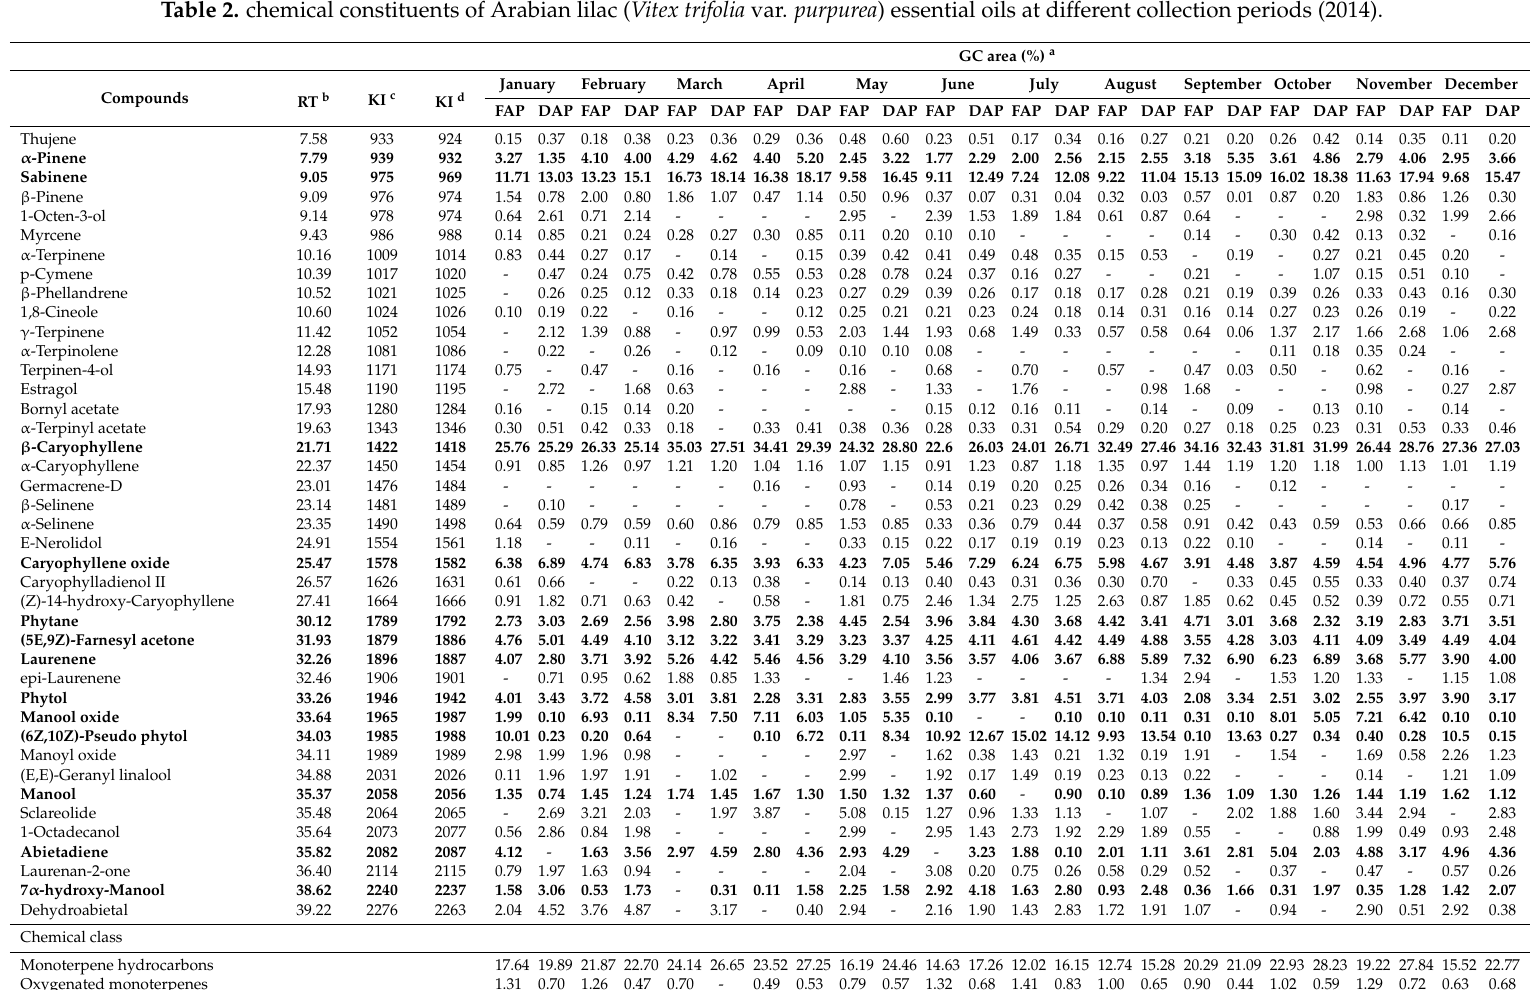
Table 2. chemical constituents of Arabian lilac ( Vitex trifolia var. purpurea ) essential oils at different collection periods (2014).